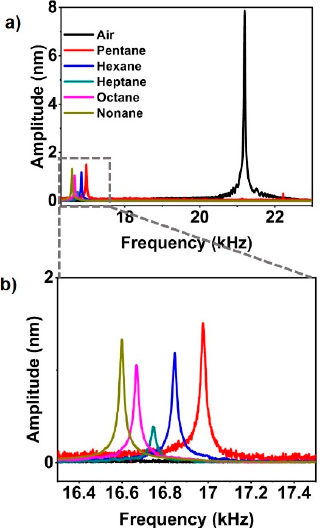
Figure 3. Characterization of resonance frequency of the microchannel cantilever filled with a series of alkanes ( a ) with and ( b ) without the resonance peak of empty channel cantilever. alkanes ( a ) with and ( b ) without the resonance peak of empty channel